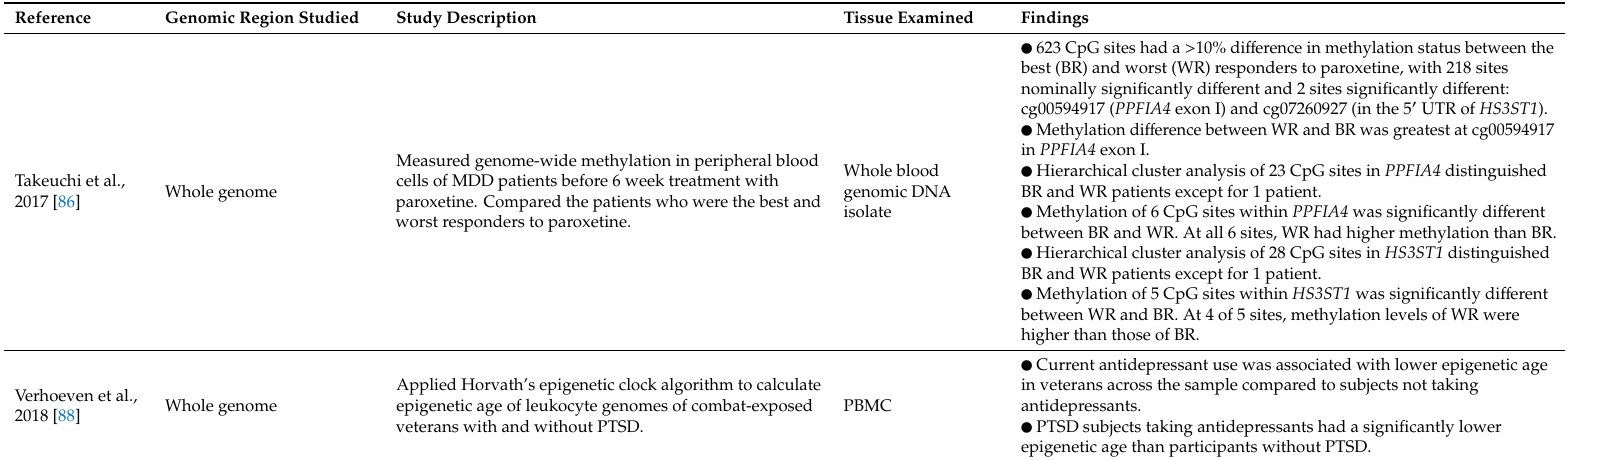
Table 6. Summaries of studies exploring relationship of antidepressants and whole genome DNA